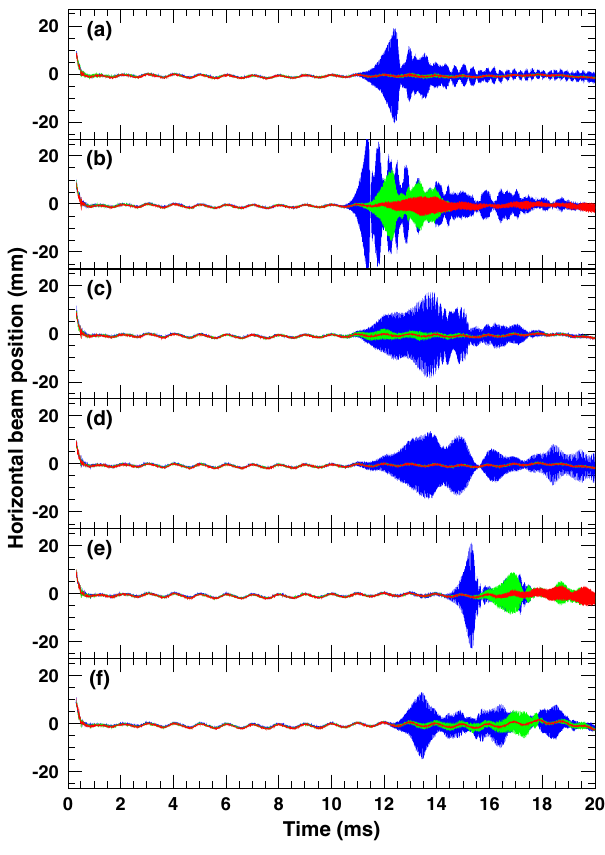
FIG. 29. Horizontal beam positions over the whole time of 20 ms measured for the beam intensity of 1 MW with the six sets of tune variations (a) – (f) given in Fig. 28, where the color variations show differences in the degree of chromaticity cor- rection; (blue) the natural chromaticity is fully corrected to zero at injection with dc sextupole fields, (green) only a quarter of the natural chromaticity is corrected at injection with dc sextupole fields, and (red) no chromaticity correction is